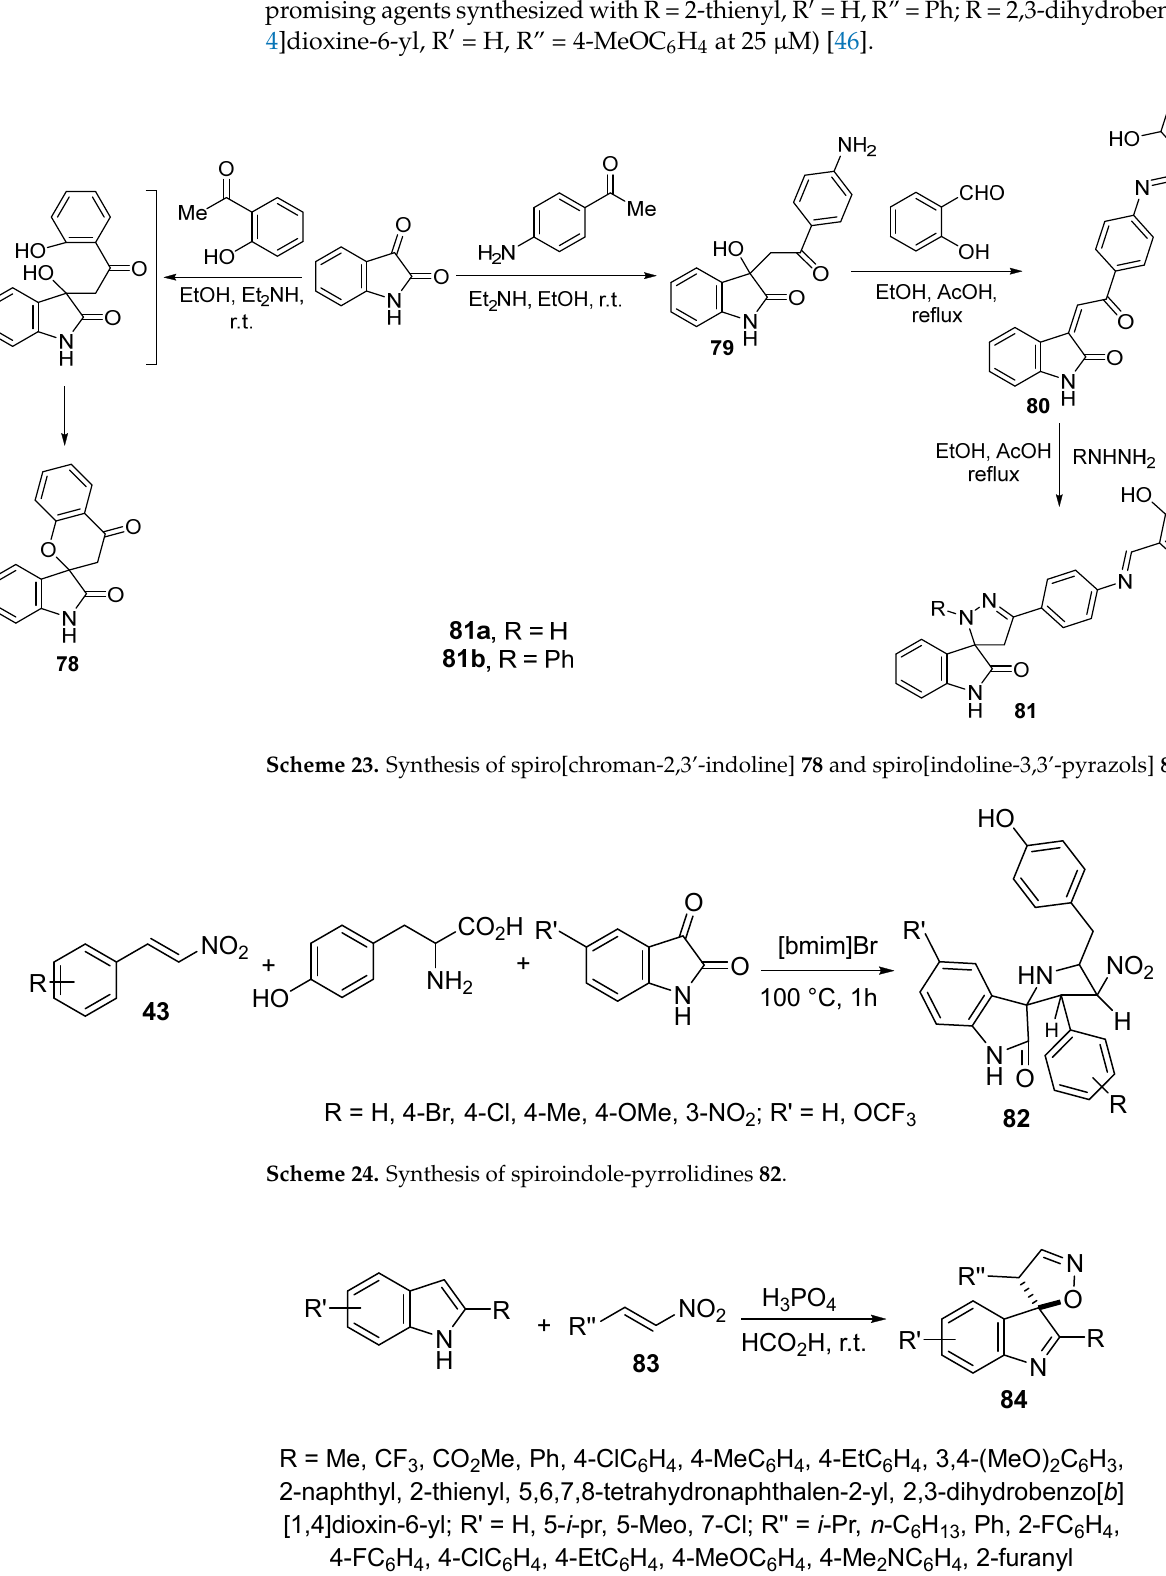
Scheme 25. Synthesis of spiro[indole-3,5 ′ -isoxazoles] 84 .